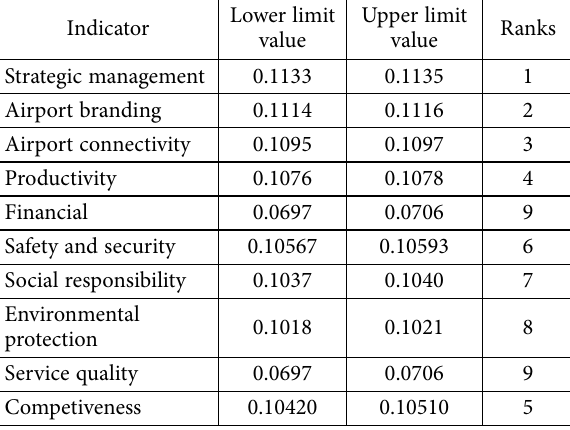
Figure 1. Main steps of this study Table 4. The weights of indicators via application of BWM plus their